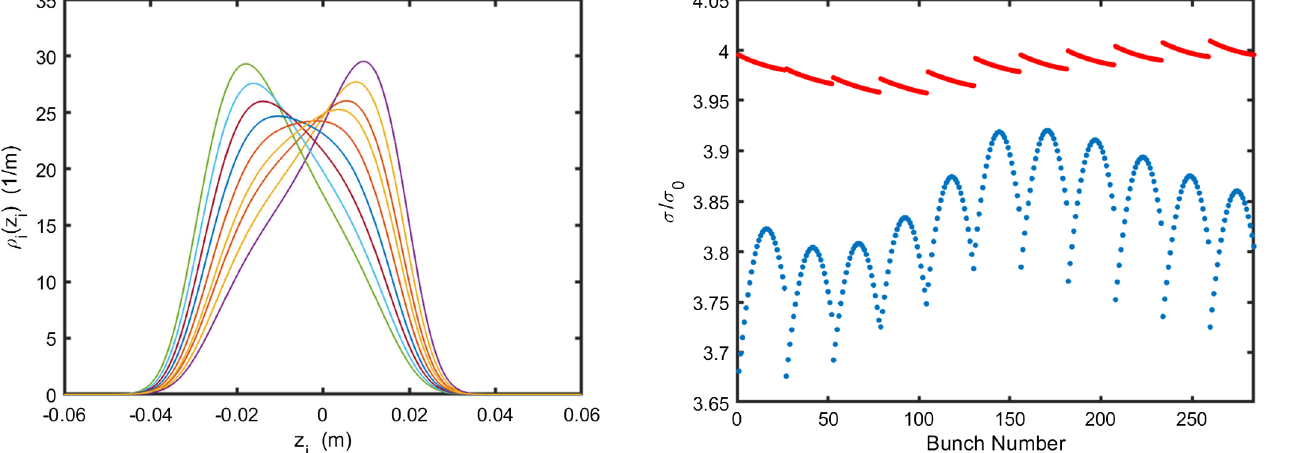
FIG. 4. Charge densities in a train of 26, surrounded by gaps of 4 buckets, fill C2, MC beam loading included, I